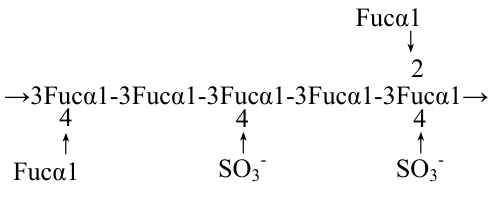
Figure 1. Pankter model for the average structure of